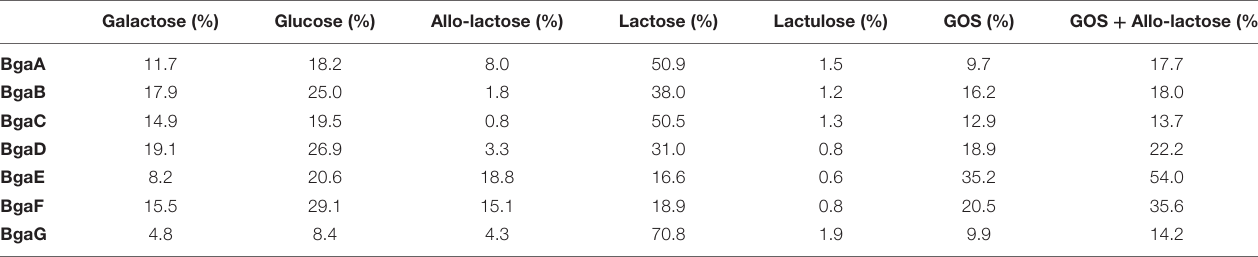
TABLE 4 | HPAEC quantitative analysis of obtained GOS mixtures. Galactose (%) Glucose (%) Allo-lactose (%) Lactose (%) Lactulose